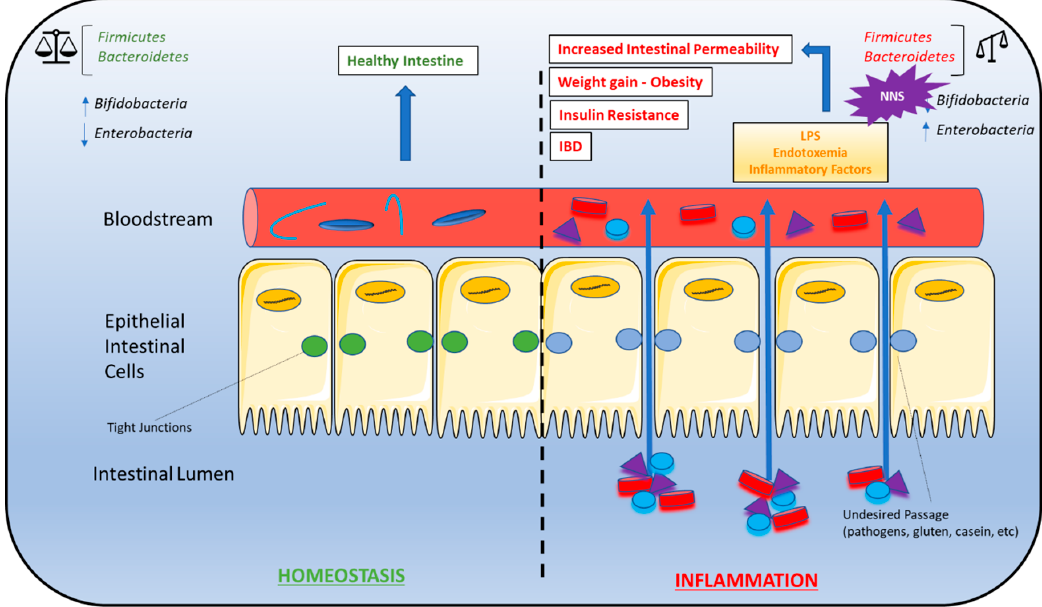
Figure 2. Gut microbiota dysbiosis and metabolic syndrome. Dysbiosis of the Firmicutes:Bacteroidetes ratio is associated with several conditions characteristic of metabolic syndrome, including weight gain/obesity, insulin resistance, high-fat diets, gut permeability, and inflammatory bowel disease (IBD). As a result, NNS consumption may contribute to the development of these conditions due to alterations in the Firmicutes:Bacteroidetes ratio. A bifidobacteria decrease combined with an enterobacteria increase leads to endotoxemia that causes a chronic low-grade inflammation associated with some pathological conditions such as insulin resistance and increased gut permeability. A right balance in the microbiota may be considered in gut homeostasis and maintaining the microbiota can be considered prebiotics and restore eubiosis in some pathological conditions. Abbreviations: IBD, inflammatory bowel disease; NNS, non-nutritive sweeteners.